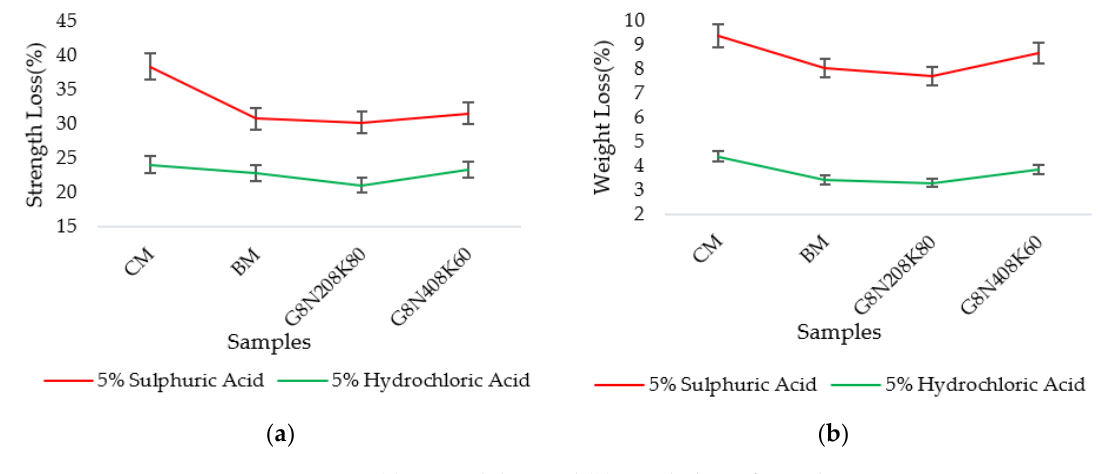
Figure 15. ( a ) Strength loss and ( b ) weight loss of samples.